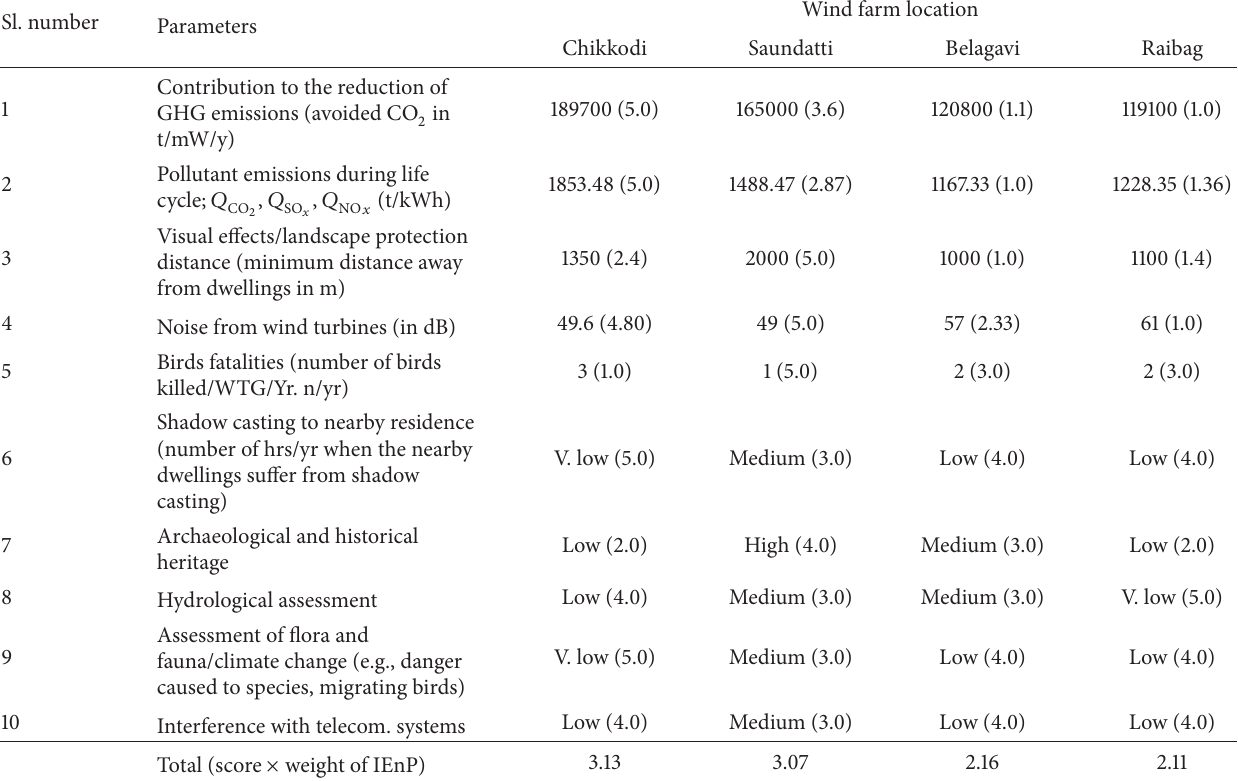
Table 4: Comparison of the wind farms based on environmental performance indicators (IEnP). Sl.